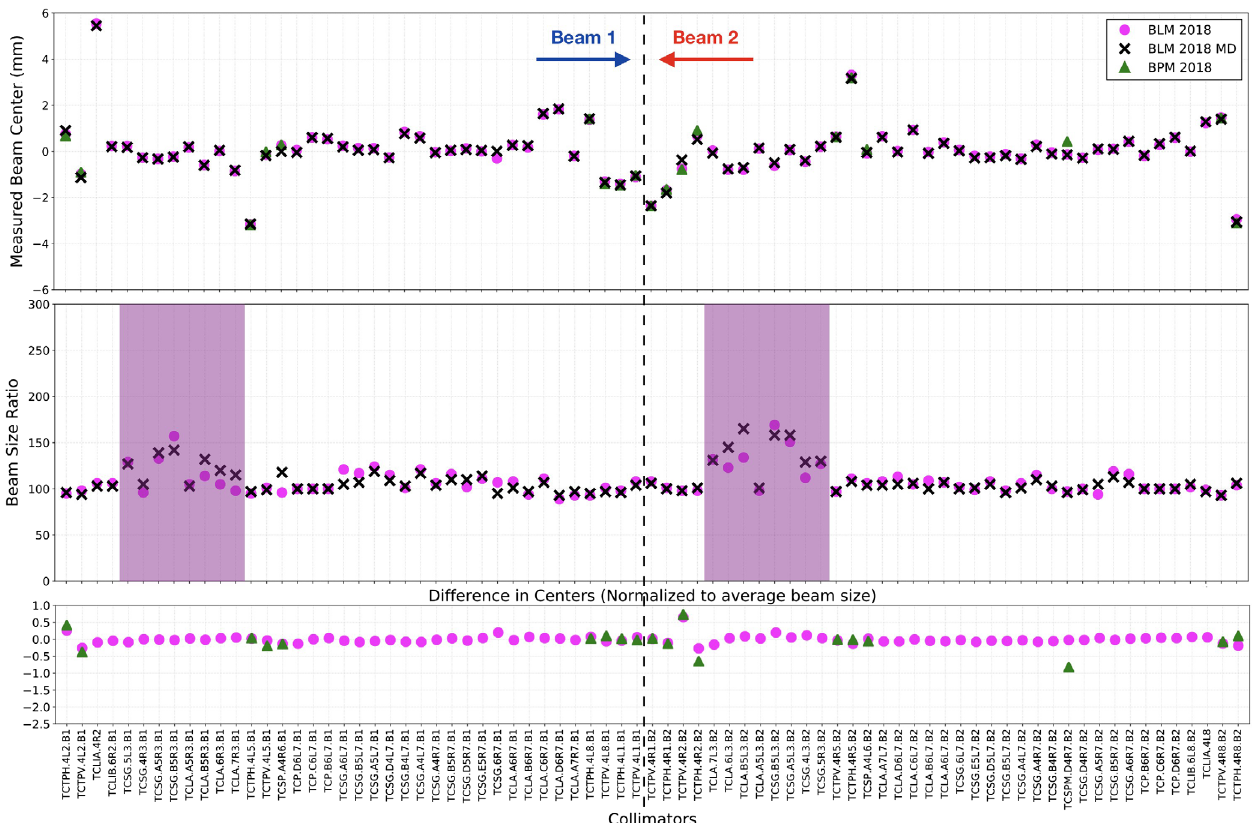
FIG. 14. Parallel alignment MD results at injection, comparing the beam centers (top graph) and beam size ratios (middle graph) to the 2018 injection commissioning results using BLMs and BPMs. The difference in centers normalized by the average beam size is presented on the bottom graph.